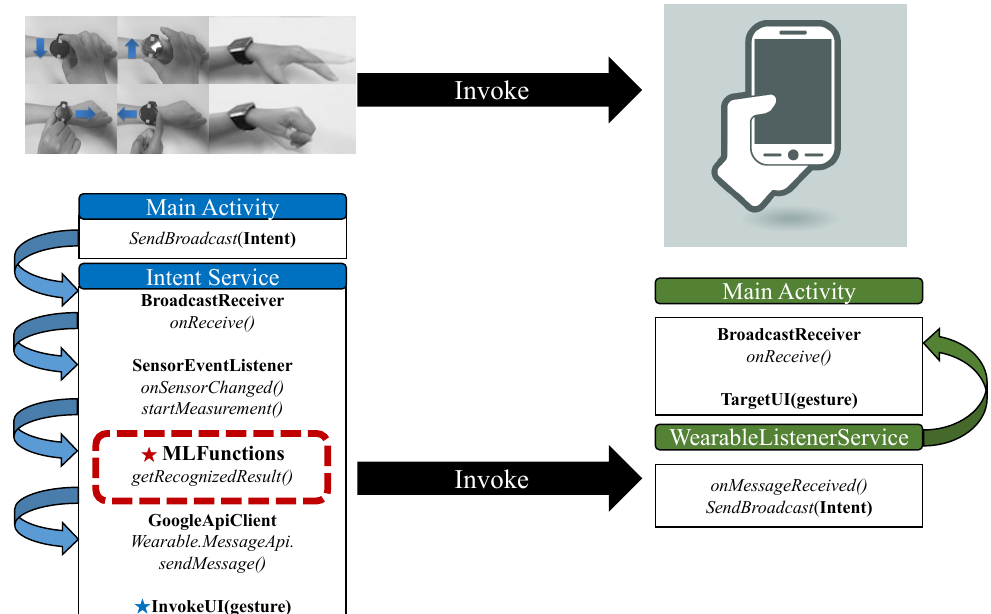
Figure 12. The motion UI application for